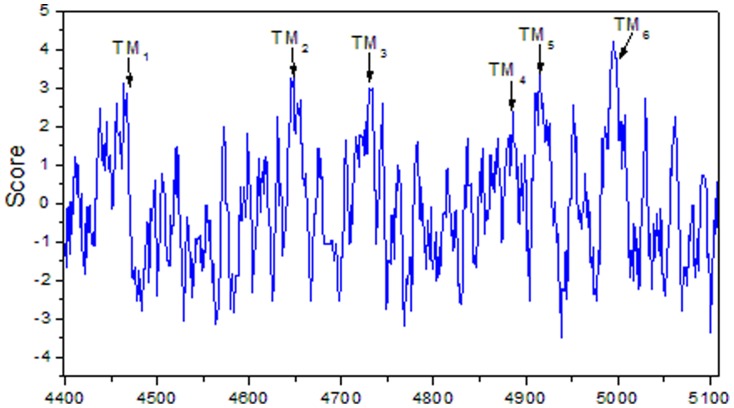
Hydropathy profile of the C-terminus OfRyR amino acids.The vertical axis indicates the hydropathy index, and the horizontal axis indicates the amino acid residue numbers. The positions of the predicted transmembrane segments were indicated by the arrows.